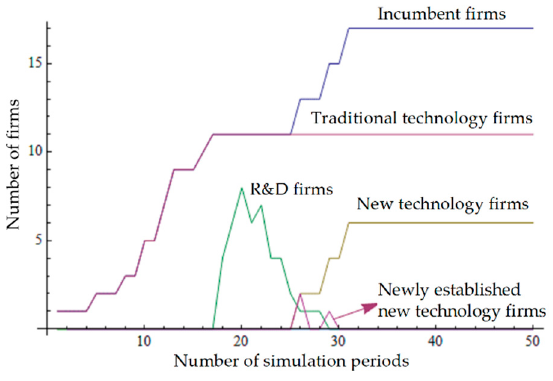
Figure 1. Change in the number of firms.